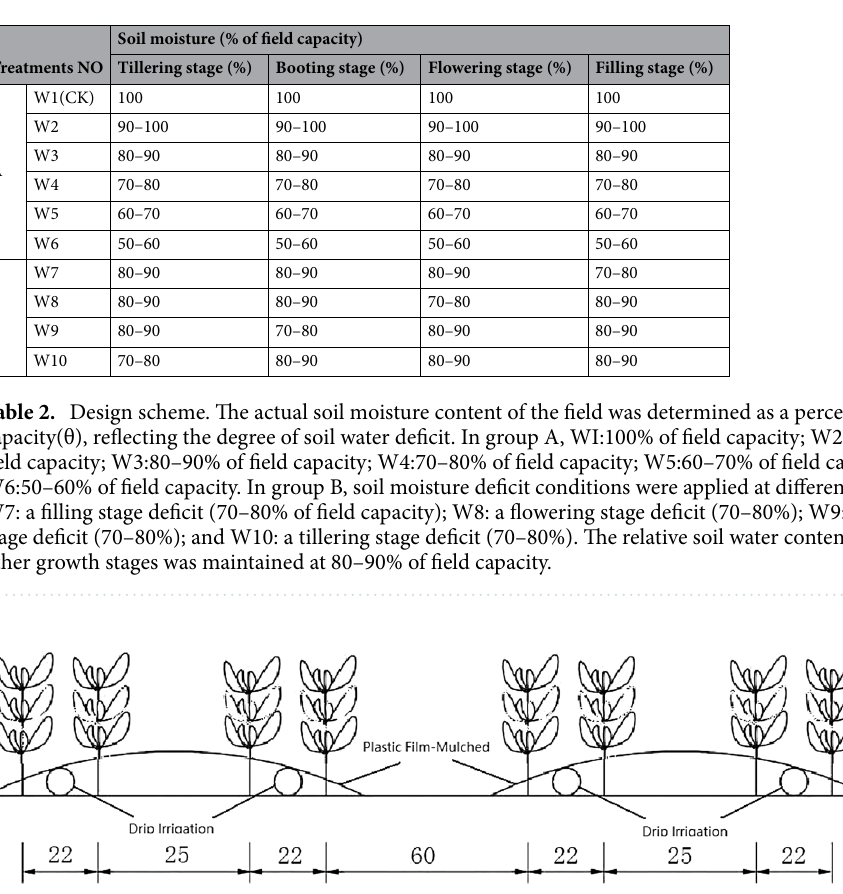
Figure 1. Planting